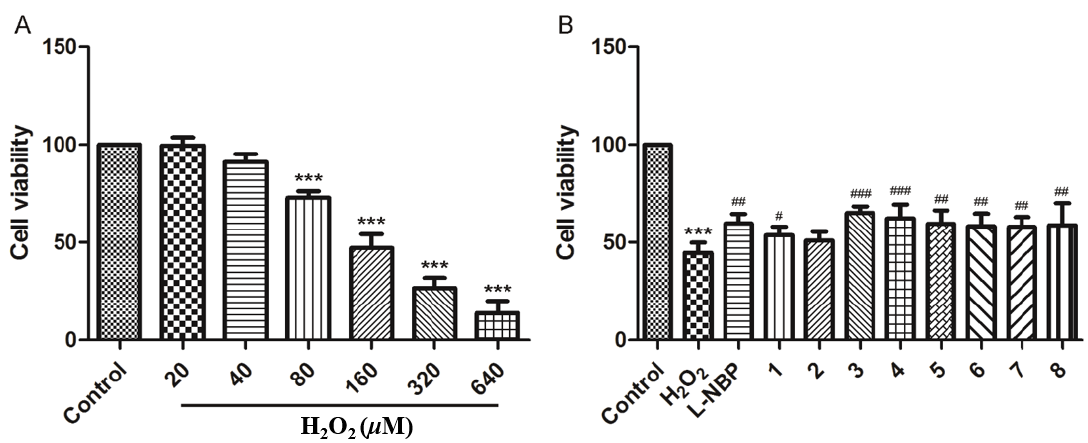
Figure 6. ( A ) Toxicity of different H 2 O 2 concentrations in SH-SY5Y cells; ( B ) neuroprotective effect of Figure 6. (A) Toxicity of different H 2 O 2 concentrations in SH-SY5Y cells; (B) neuroprotective effect of compounds 1 – 8 against H 2 O 2 -induced toxicity in SH-SY5Y compounds 1 – 8 against H 2 O 2 -induced toxicity in SH-SY5Y cells.